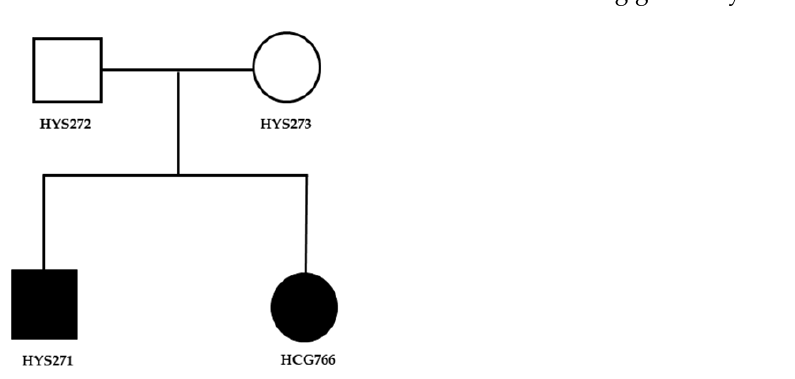
Figure 1. Pedigree of the family with two siblings affected with ID and ASD.